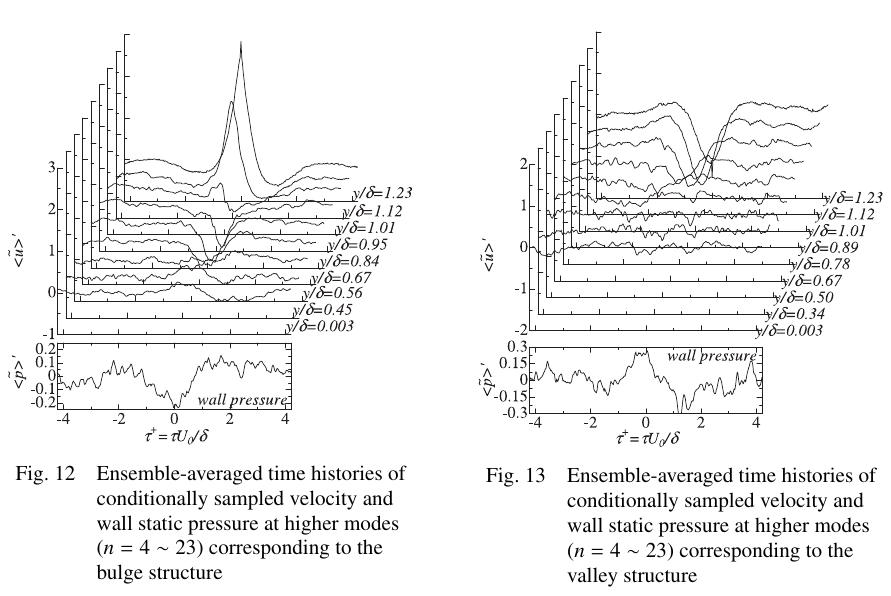
Fig. 13 Ensemble-averaged time histories of conditionally sampled velocity and wall static pressure at higher modes ( n = 4 ∼ 23) corresponding to the valley